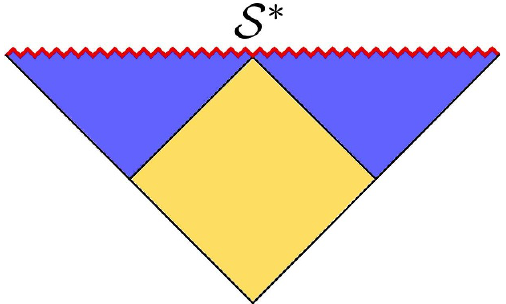
Figure 7 . When the bulk action is dominated by a negative cosmological constant, the bulk contribution to the AC terminal complexity of S ∗ is subextensive. While the YGH contribution is extensive over S ∗ , the bulk contribution is more negative for the larger set (yellow) than it is for the union of the smaller sets (blue).